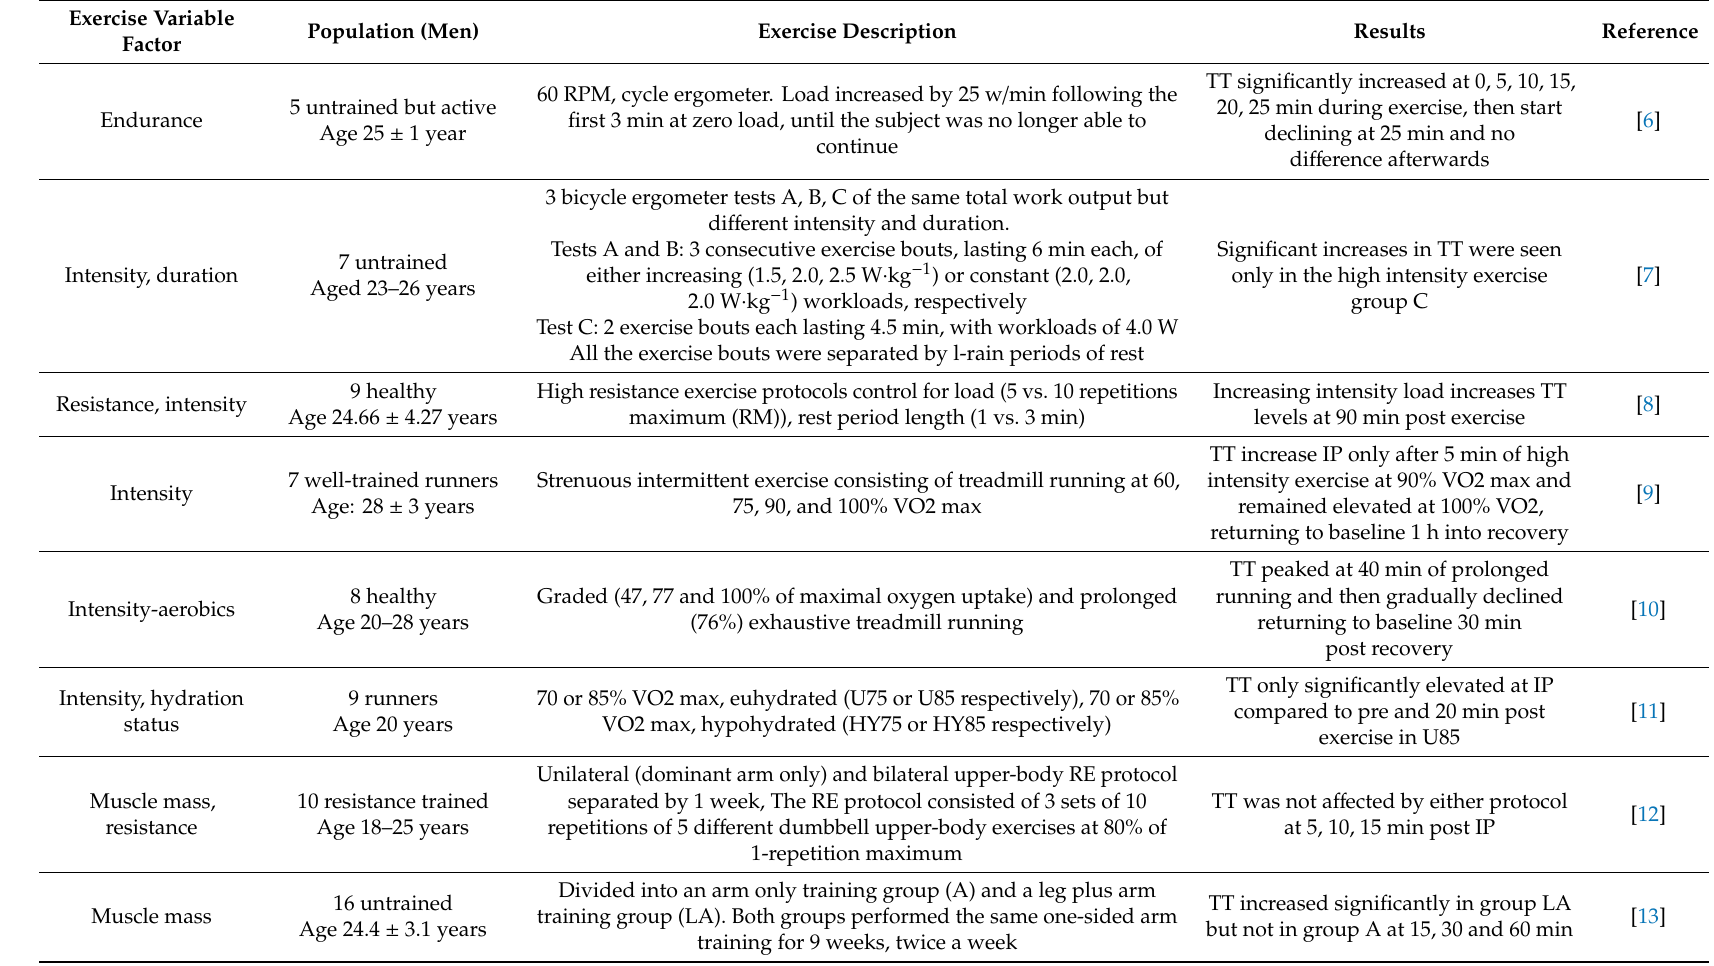
Table 1. Summary of analyzed data on the e ff ect of exercise on testosterone